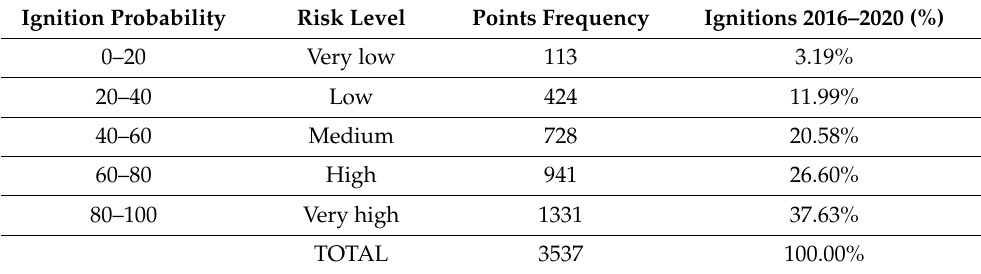
Table 3. Percentage of fire ignition during 2016–2020 according to model probability levels.